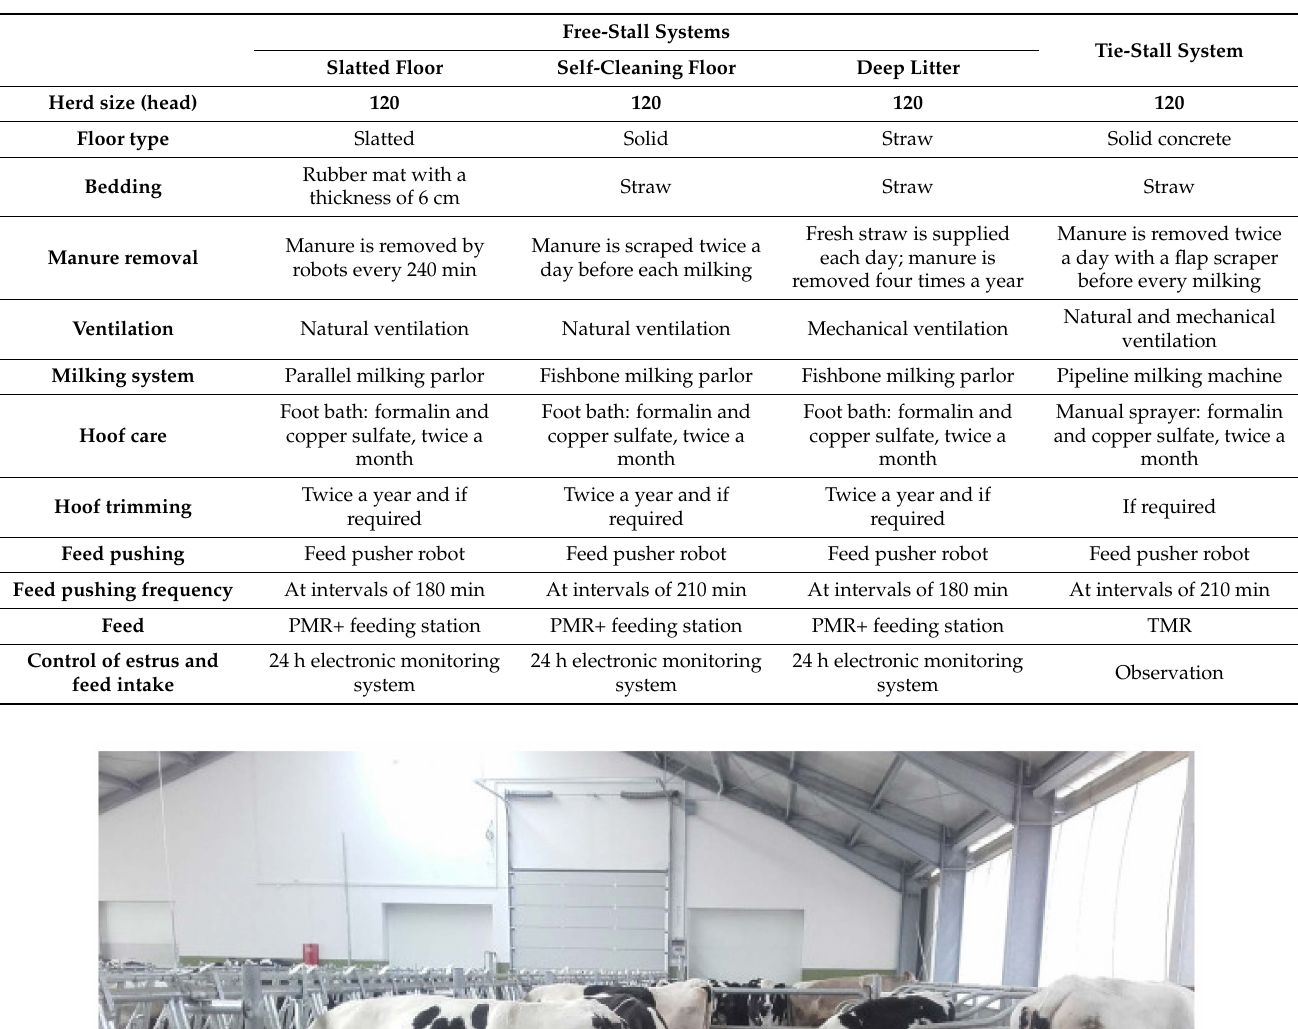
Table 1. Characteristics of the evaluated housing systems.